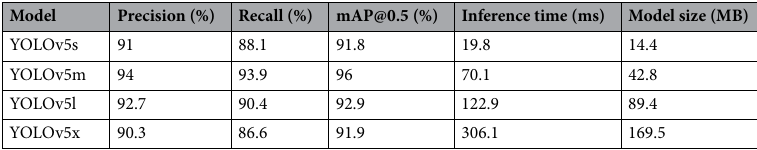
Table 2. Comparison of the performance metrics for the four pretrained models.